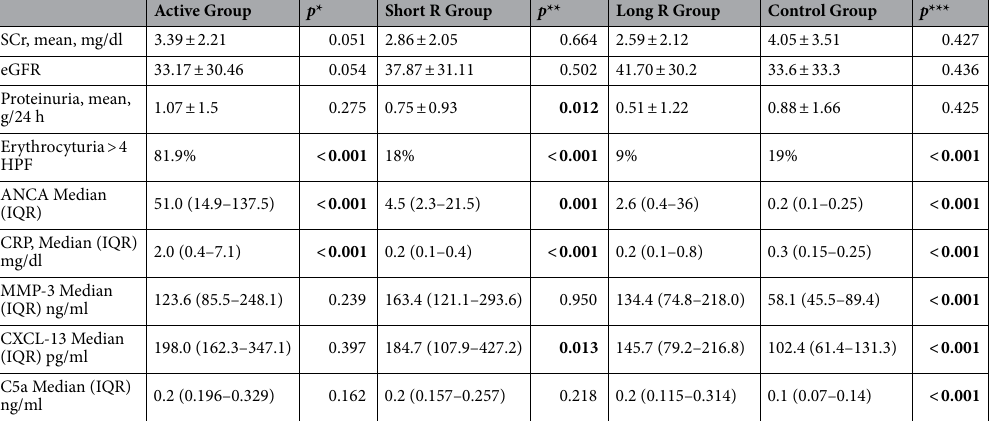
Table 2. Laboratory findings in the study groups. ANCA anti-neutrophil cytoplasmic autoantibody, CRP C-reactive protein, CXCL-13 chemokine CXC ligand 13, HPF high power field, MMP-3 metalloproteinase 3, SCr serum creatinine concentration. p * for comparison of Active Group with Short-term remission Group, p ** for comparison of Long-term remission Group with Active Group, p *** for comparison of Control Group with Active Group. p values which are statistically significant are